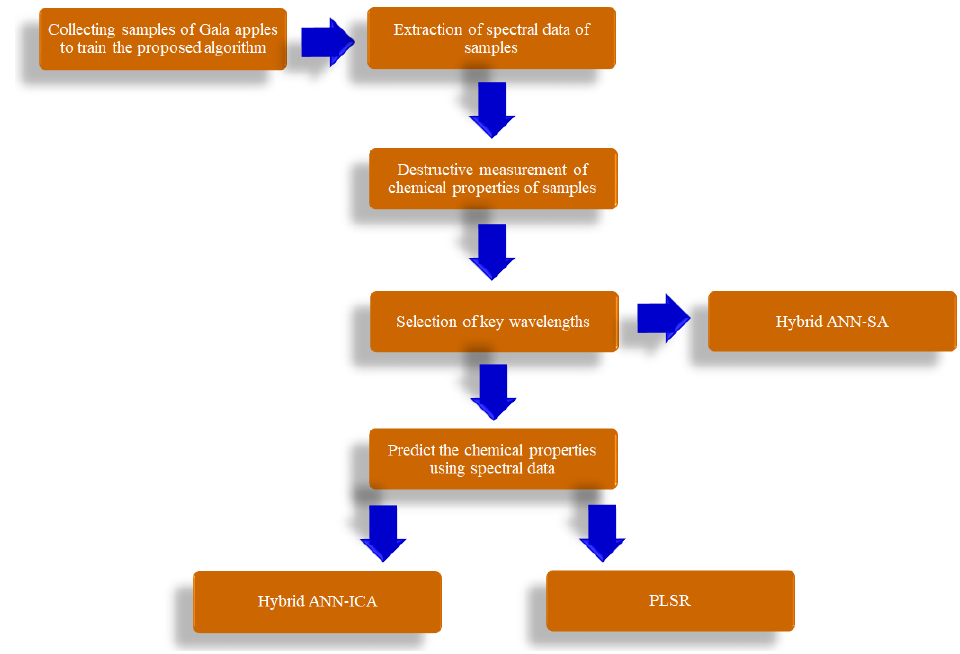
Figure 1. Schematic view of different steps of proposed algorithm in this research.